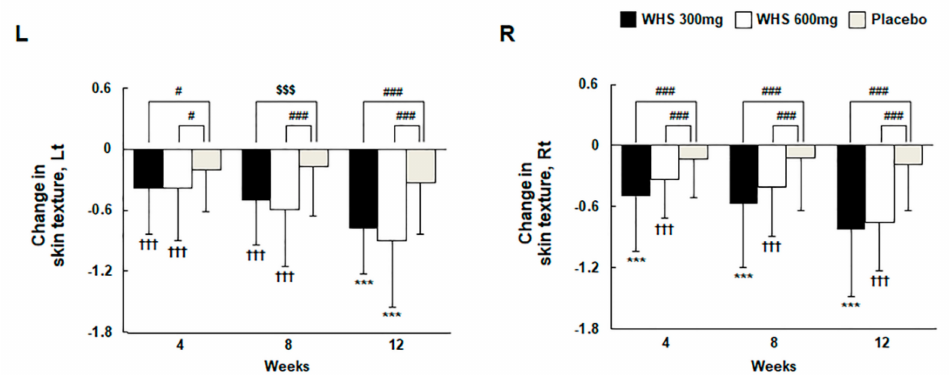
Figure 5. Changes in skin texture with WHS or placebo administration for 12 consecutive weeks.